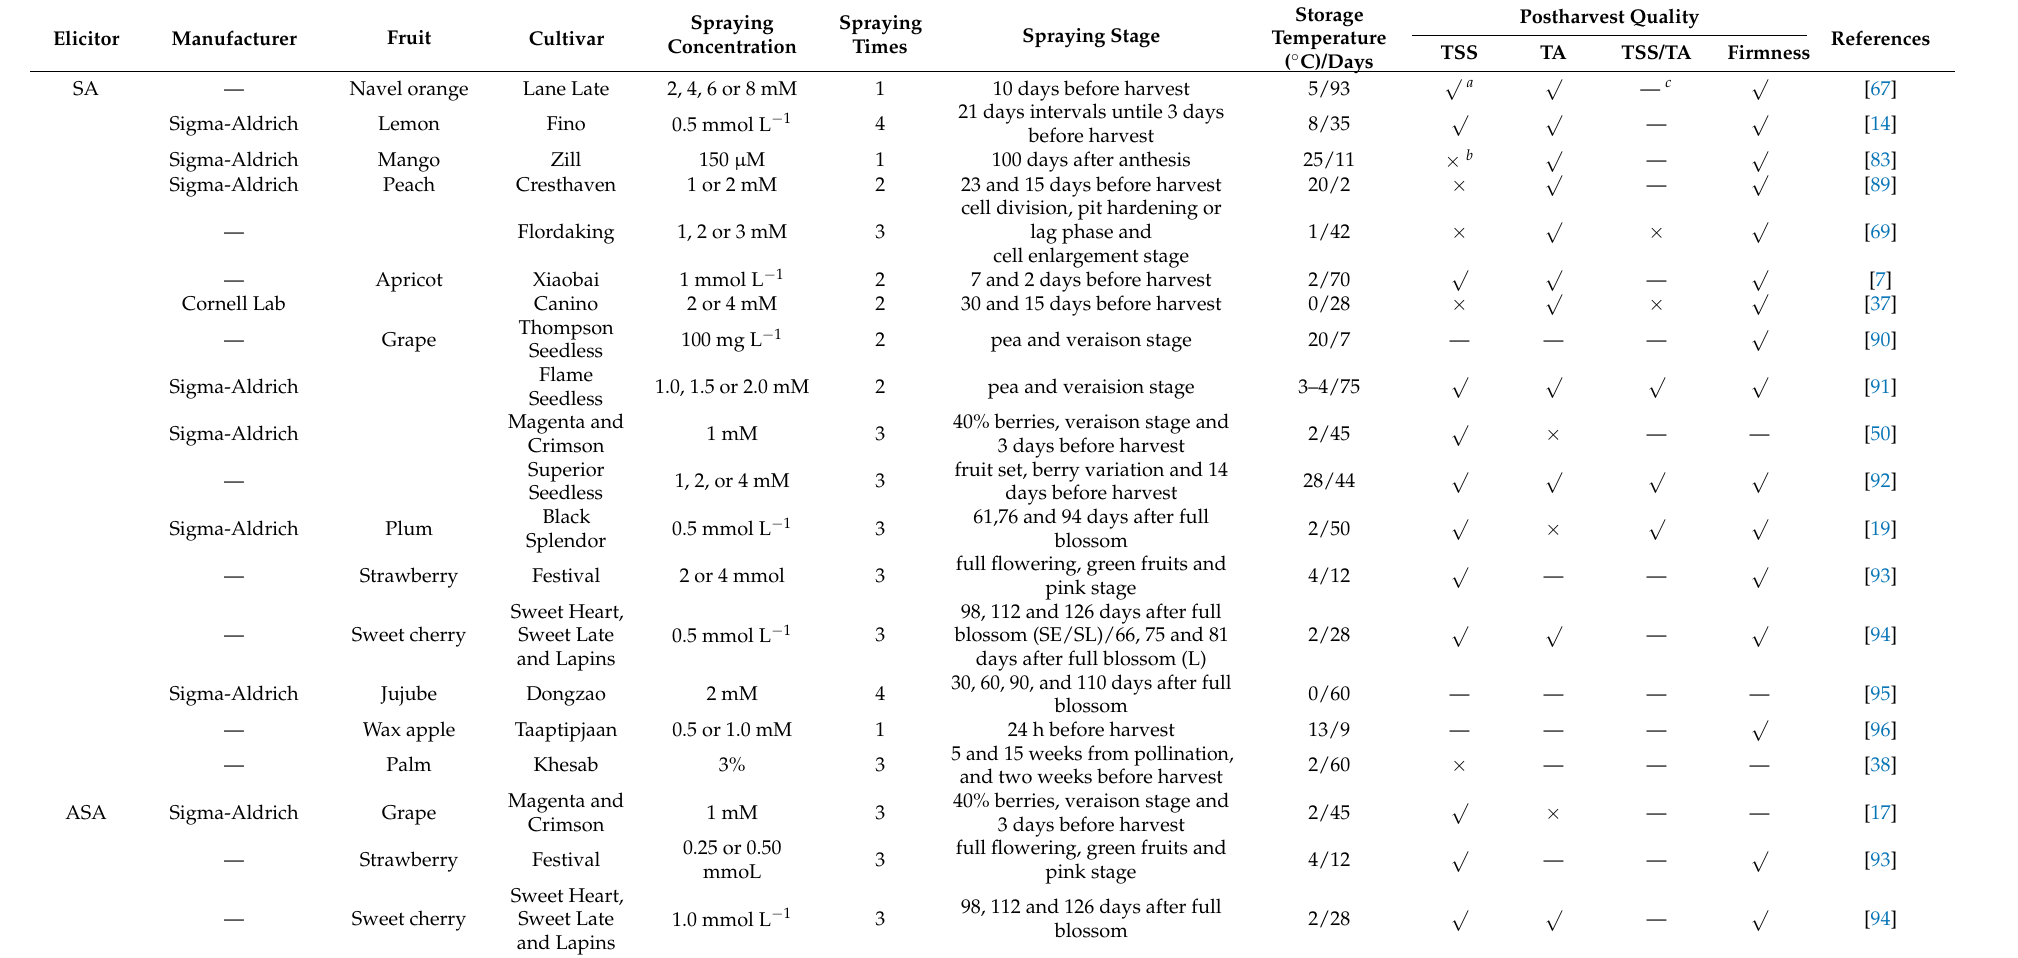
Table 3. Preharvest elicitors spray maintains postharvest quality in